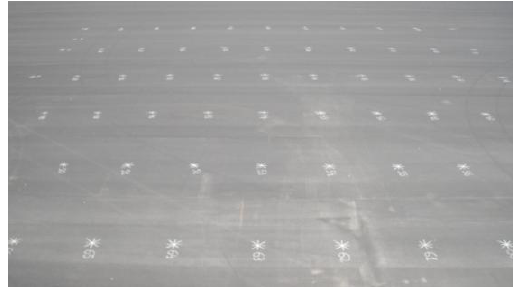
Figure 4. Field calibration surface with the targets points